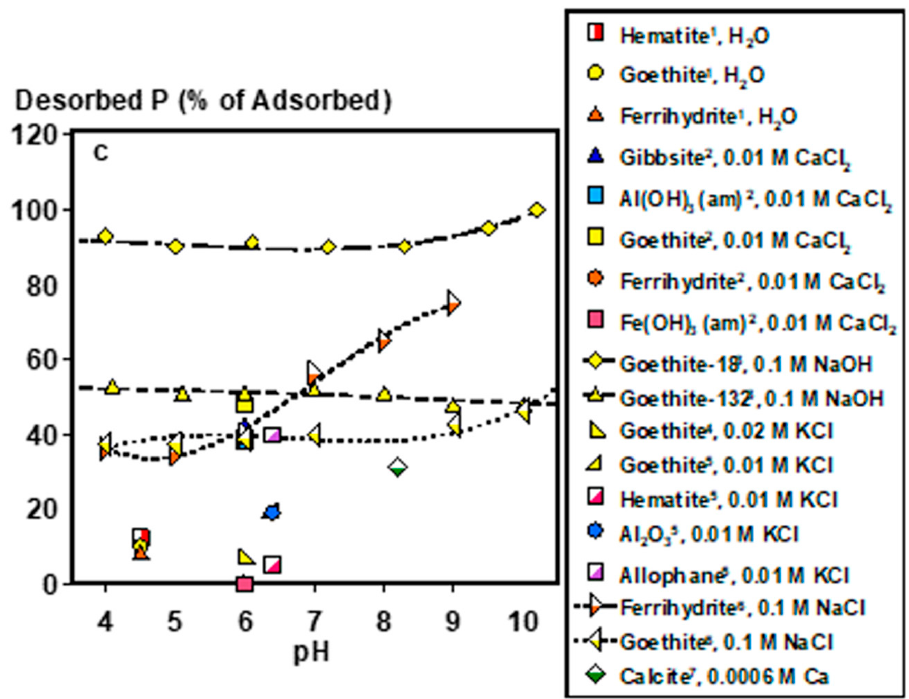
Figure 2. Soil solution pH controls: ( a ) dissolved phosphate concentrations in equilibrium with major phosphate minerals, ( b ) adsorbed P concentrations on to various soil minerals, and ( c ) desorbed P from di ff erent soil minerals as fractions of adsorbed concentrations. *Plotted data points were calculated by Visual MINTEQ Ver. 3.1 at 0.001 KCl and excess concentrations of each mineral (2 g L − 1 ). Adsorption and desorption data were computed from the following works: 1 [39], 2 [34], 3 [40], 4 [41], 5 [32], 6 [42], 7 [43]. Lines are meant to guide the eye and do not represent model